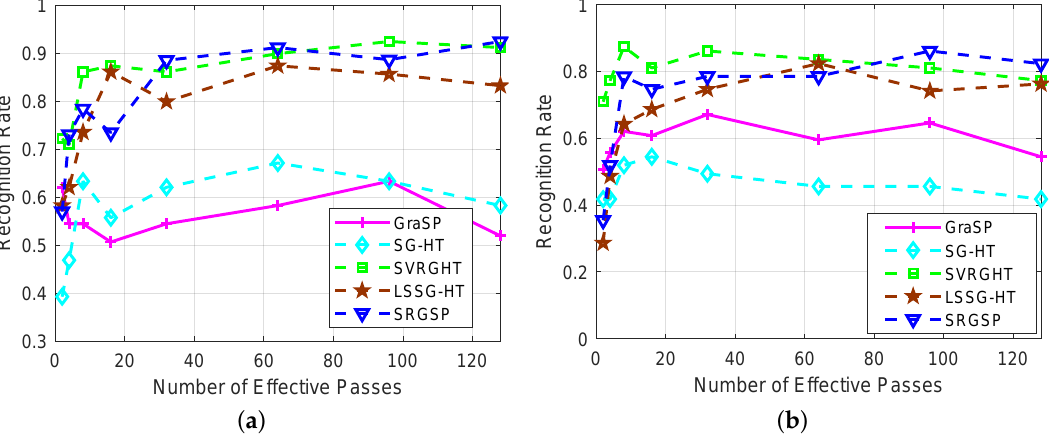
Figure 9. Comparison of recognition rates of all the algorithms on the extended Yale B and AR databases with the Gaussian noise level σ = 0.25. ( a ) The Yale B dataset; ( b ) the AR dataset.